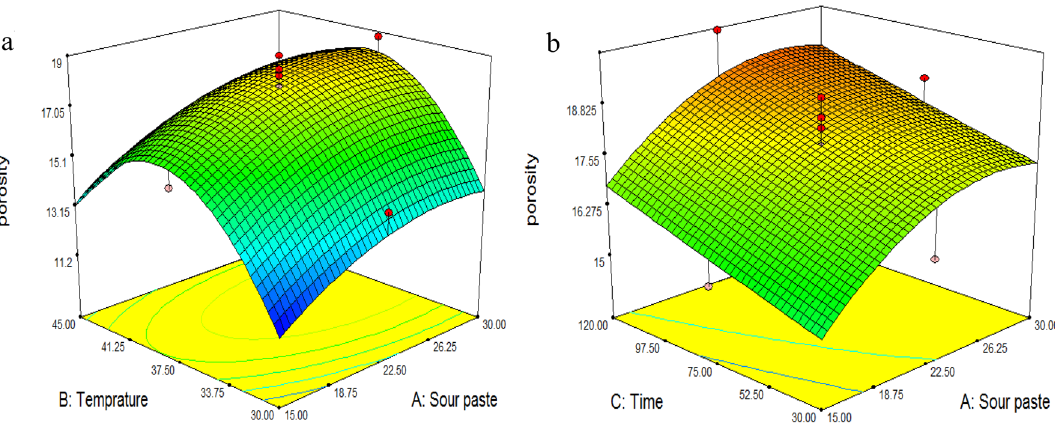
Fig. 2 Effect of temperature and sourdough amount a and fermentation time and sourdough amount b on porosity of Barbari bread prop-